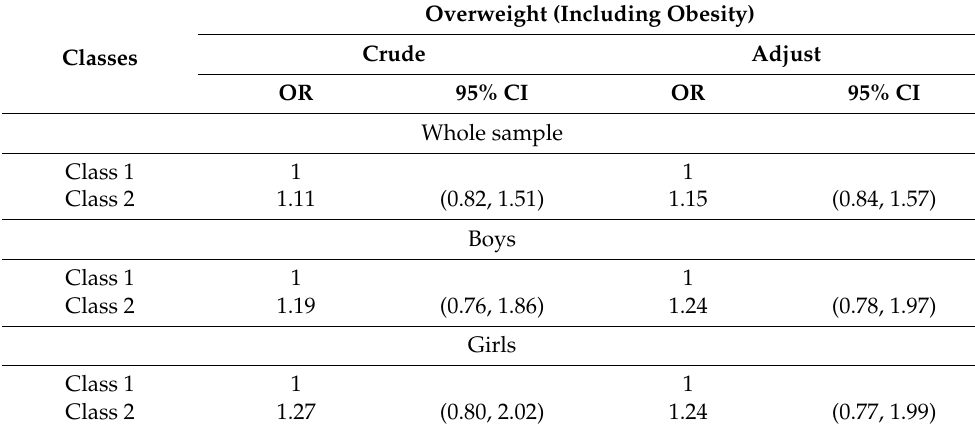
Table 2. Latent classes associated with weight status ( n = 731). Florian ó polis, Santa Catarina, Brazil,